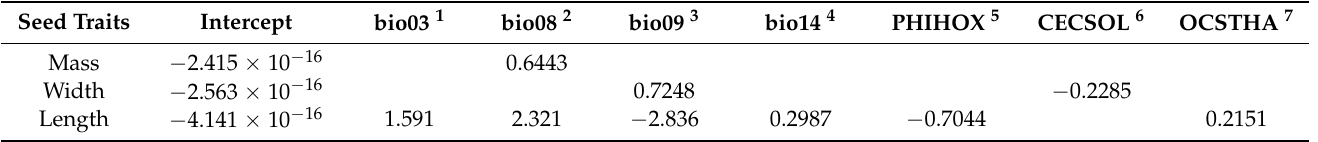
Figure 3. Latitudinal gradients of seed traits and the significant correlation between the seed traits and climatic variables. The climatic variables selected from Table 2 and only with the p -value < 0.05 are presented. Table 3. Environmental variables that predict variation in measured seed traits of the pine populations. Model predictor variables were selected using forward selection with the criterion that variables were included if the model Akaike information criterion (AIC)